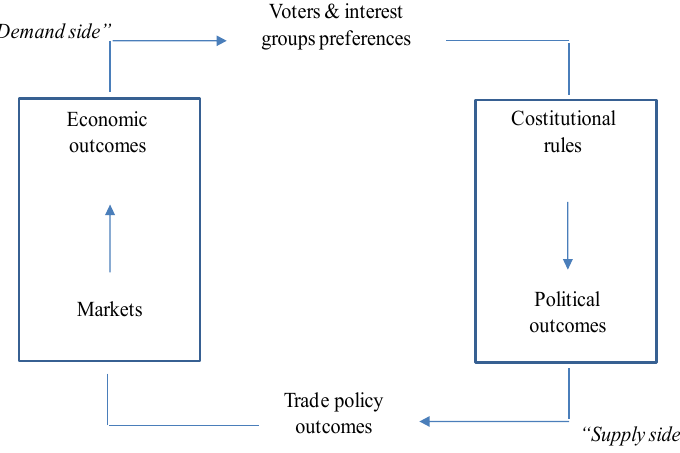
Figure 6. The democratic policymaking